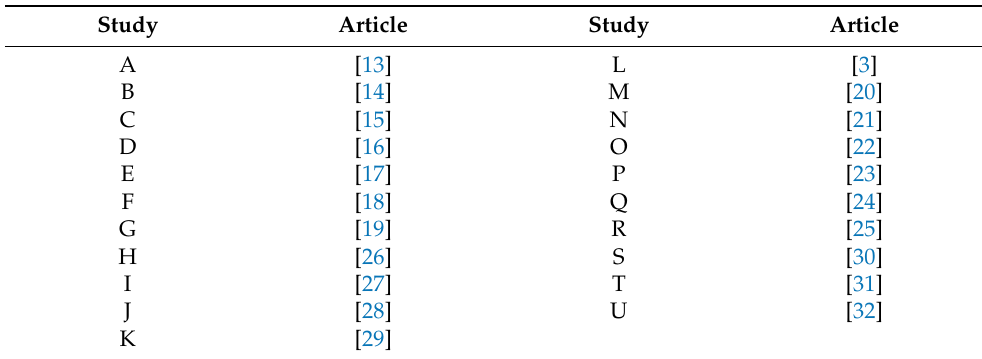
Table 3. Selected primary studies.